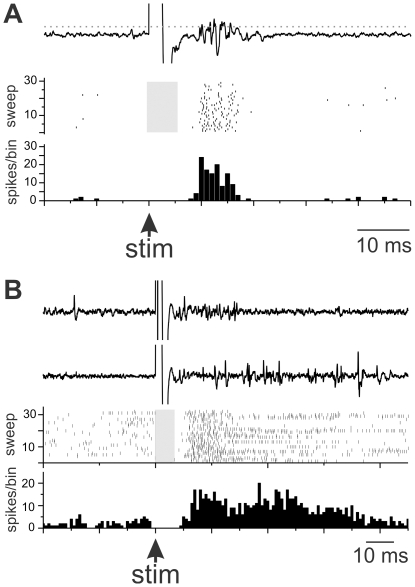
Stimulation of MMAN functionally excites the ipsilateral HVC.A. Example of the short latency response from MMAN stimulation to HVC response. Top trace is an exemplar of the raw HVC response to MMAN stimulation (large artifact). The dotted grey line denotes the spike threshold set by the user. Middle trace, raster plot of responses to thirty stimulus pulses in MMAN. Grey bar indicates time in which stimulus artifacts were removed from the plot. Bottom trace, PSTH of HVC response to MMAN stimulation. B. Longer latency response in HVC to MMAN stimulation. Top two traces, raw exemples of two HVC responses to stimulation of MMAN. Middle trace, raster plot to of HVC response to 30 MMAN stimulations. Grey bar indicates time in which stimulus artifacts were removed from the plot. Bottom trace, PSTH of the cumulative response in HVC to MMAN stimulation. For both A and B, bin size = 1 ms. A and B are from two different birds.